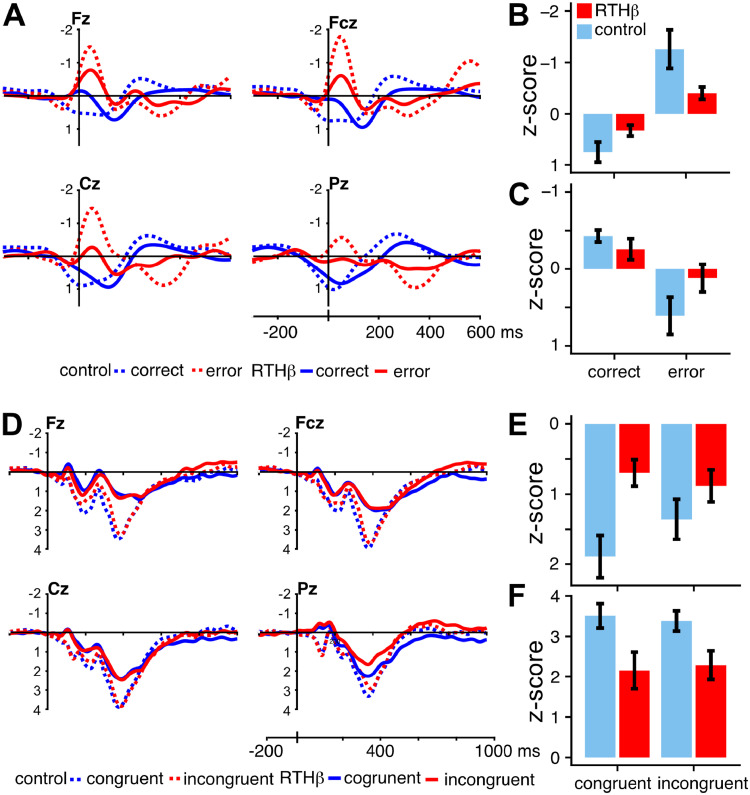
A: /-transformed response locked ERPs. B: mean z-scores of the ERN effect at Fcz. C: mean z-scores of the PE-effect at Cz. D: z-transformed stimulus locked ERPs. E: mean z-scores of the N2 effect at Fz. F: mean z-scores of P3 effect at Cz.